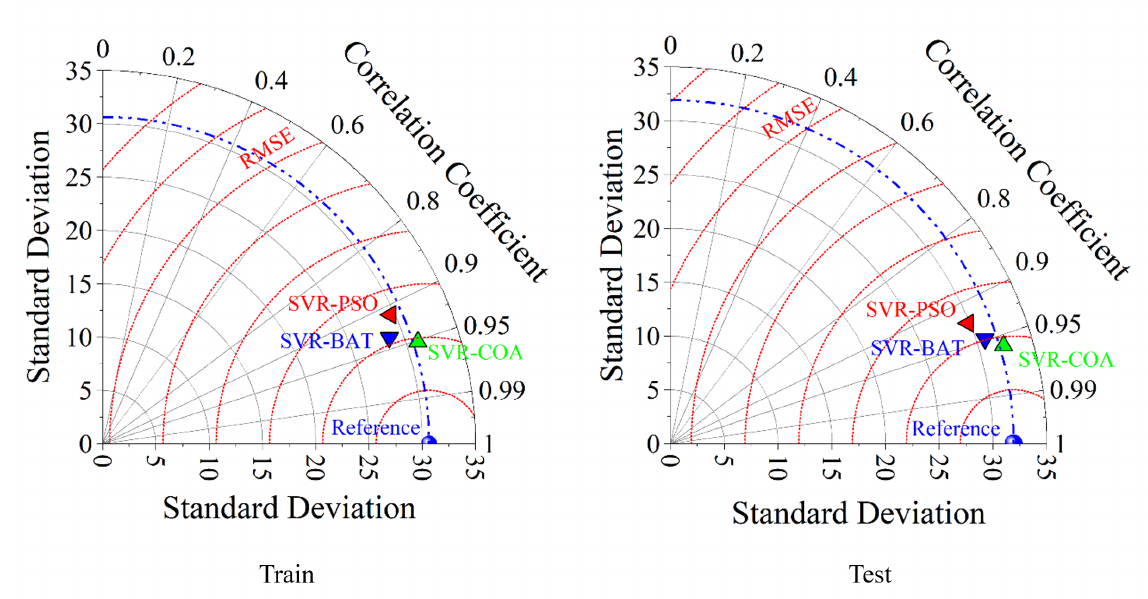
Fig. 5. The results of the Taylor